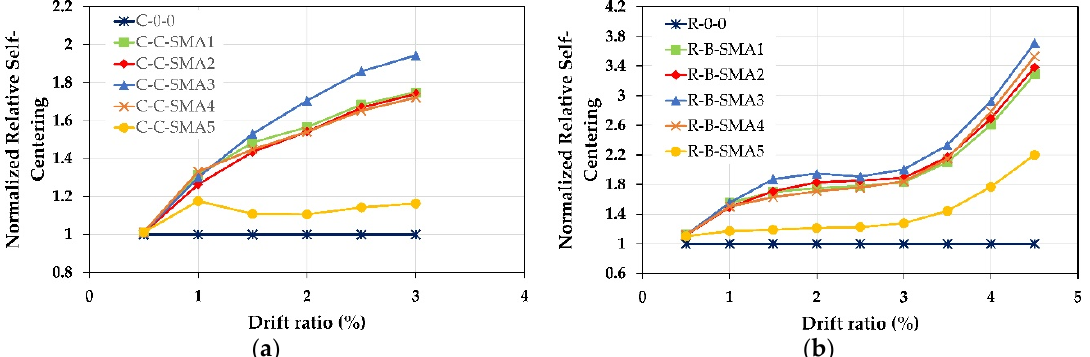
Figure 16. Normalized Relative Self Centering Efficiency versus the drift ratio: ( a ) columns of Group1; ( b ) columns of Group2.